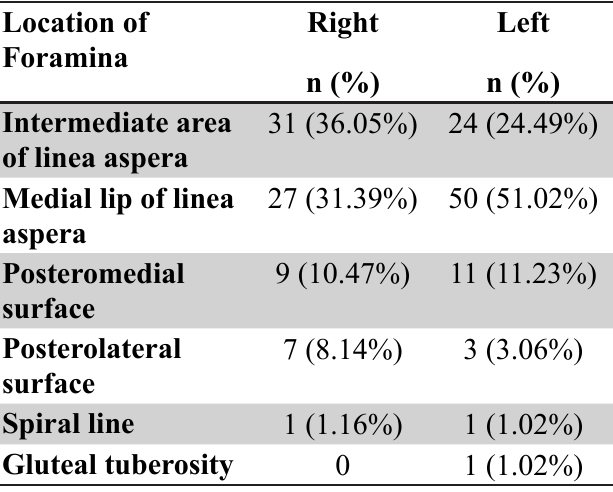
Table 2. Location of nutrient foramina on the basis of topography Location